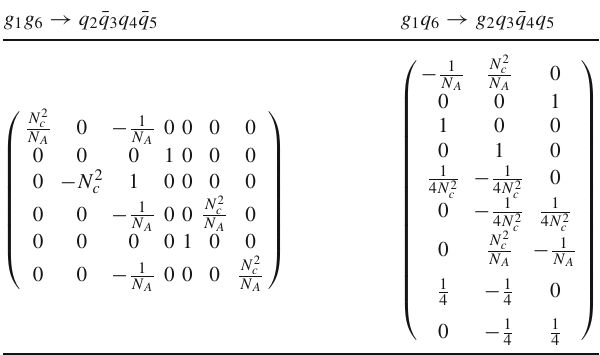
Table 11 Matrices M of structures appearing in the six-parton pro- cesses(partIV).Thesubscriptsinthesub-processindicationcorrespond to the momenta